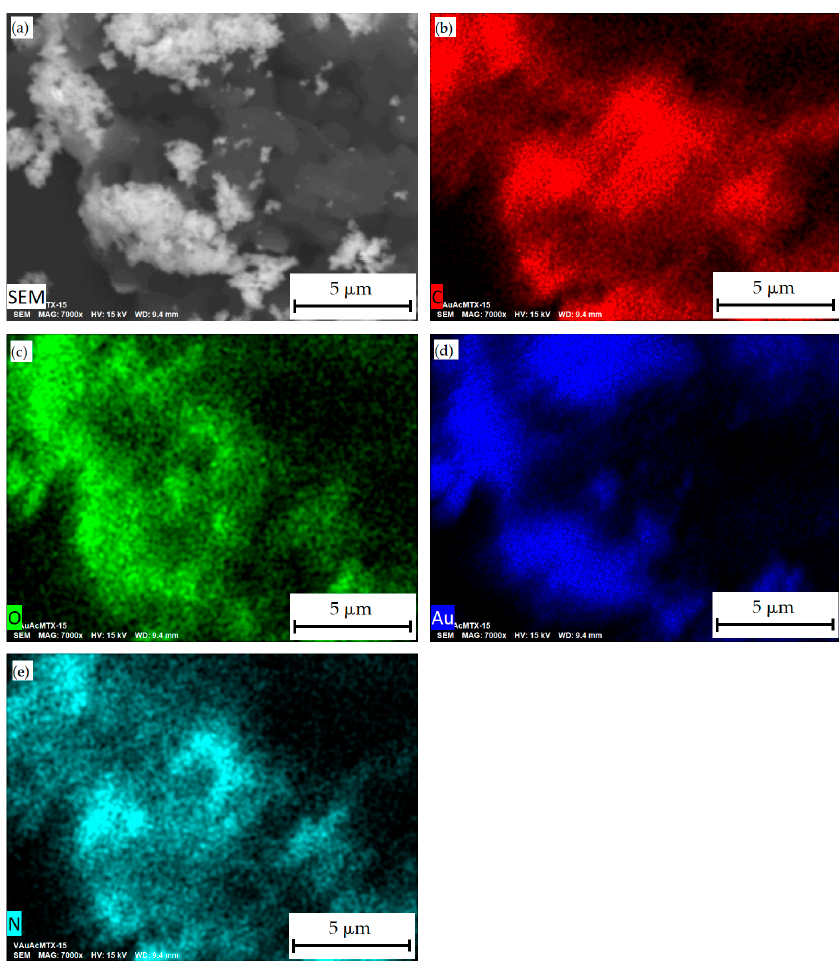
Figure 5. SEM-image of morphology of AuAcMTX conjugate nanoparticles ( a ) and its elemental mappings: C ( b ), O ( c ), Au ( d ), and N ( e ). The elemental composition of the AuAcMTX conjugate is presented in the EDX spec- trum (Figure 6).